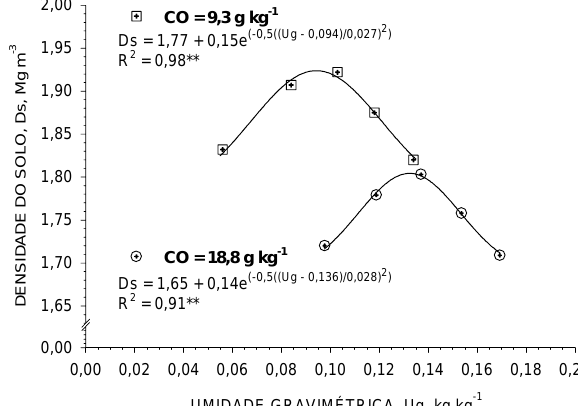
Figura 1. Curva de compactação de duas amostras de um Argissolo Vermelho-Amarelo arênico com dois diferentes teores de carbono orgânico (** modelo ajustado é significativo a p ≤≤≤≤≤ 0,01 pelo teste